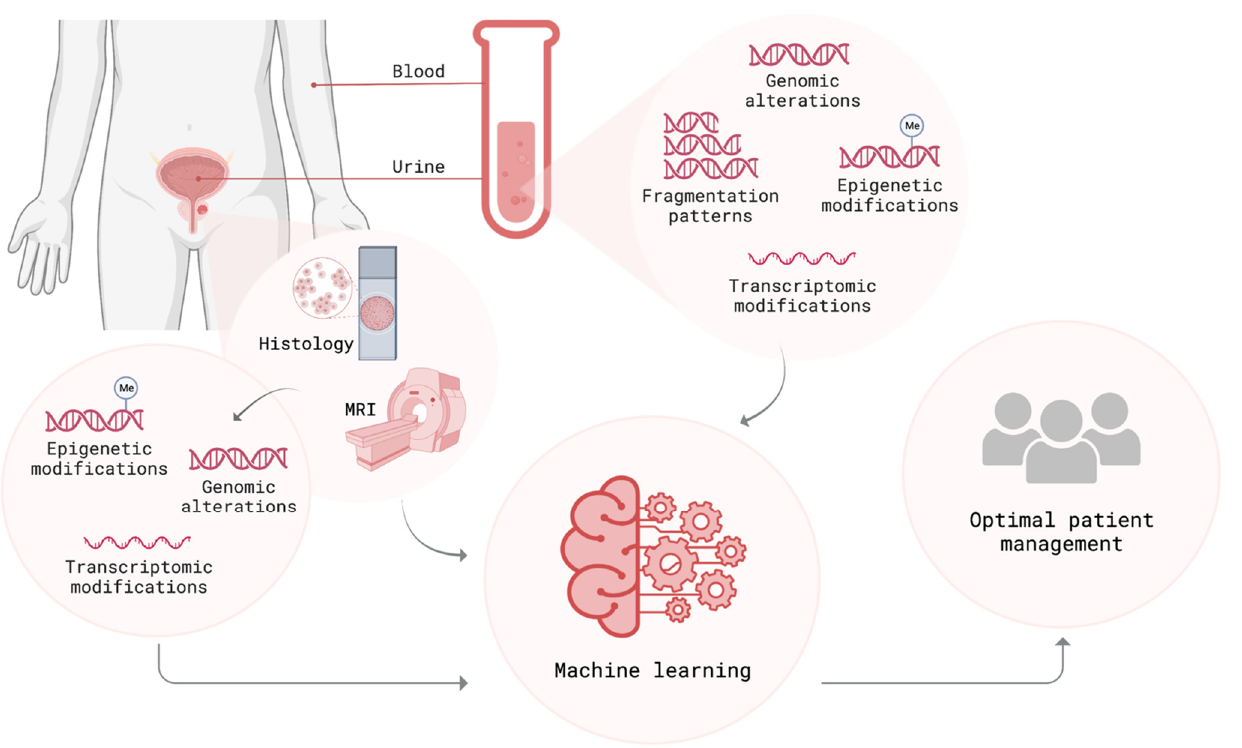
Figure 3. Multi-parametric approach converges the data derived from several sources (i.e., tissue and liquid biopsy, as well as MRI and histology) and uses them as an input for machine learning algorithms. Subsequent to this validation, this approach offers great potential to create a comprehensive patient profile and improves clinical outcomes. Created with BioRender.com (Accessed on 9 November 2022)